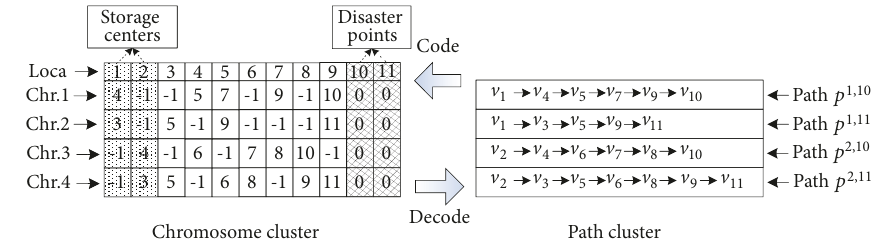
Figure 3: An example to illustrate chromosome cluster.